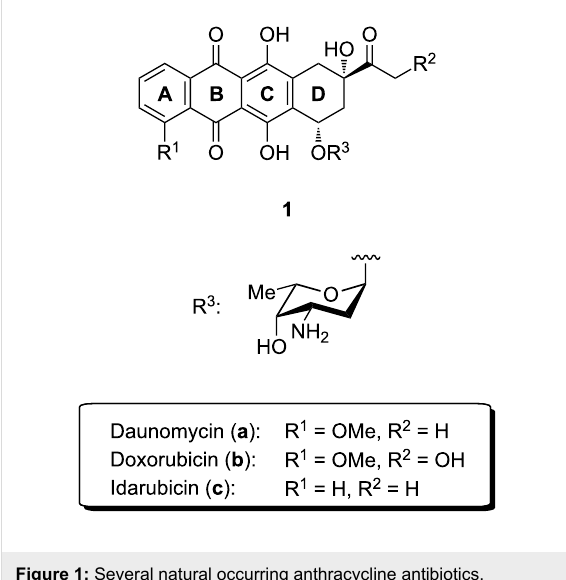
Figure 1: Several natural occurring anthracycline antibiotics.